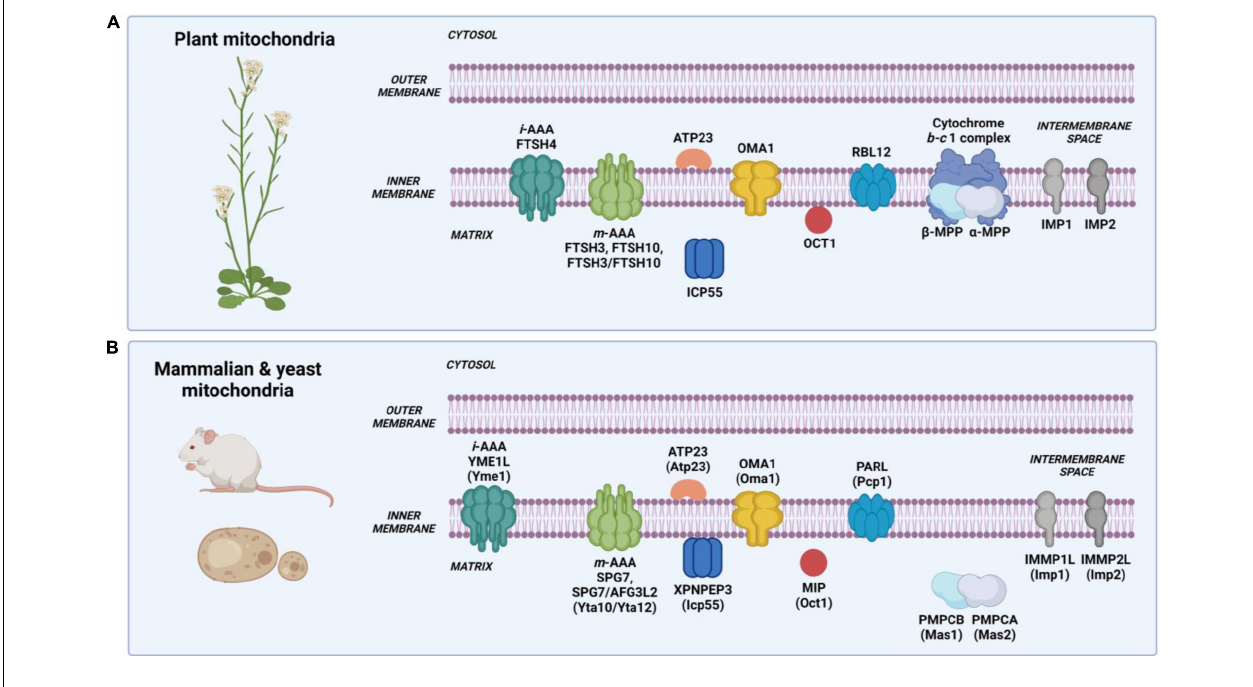
FIGURE 2 | Intramitochondrial localization and nomenclature of proteases involved in protein processing in mammalian, yeast, and plant mitochondria. (A) Processing proteases in plant mitochondria. Nomenclature based on the Arabidopsis thaliana mitochondrial proteolytic system. (B) Processing proteases in mammalian and yeast mitochondria. Nomenclature written in capital letters indicates a mammalian protease, while in brackets – a yeast protease. Created with BioRender.com.